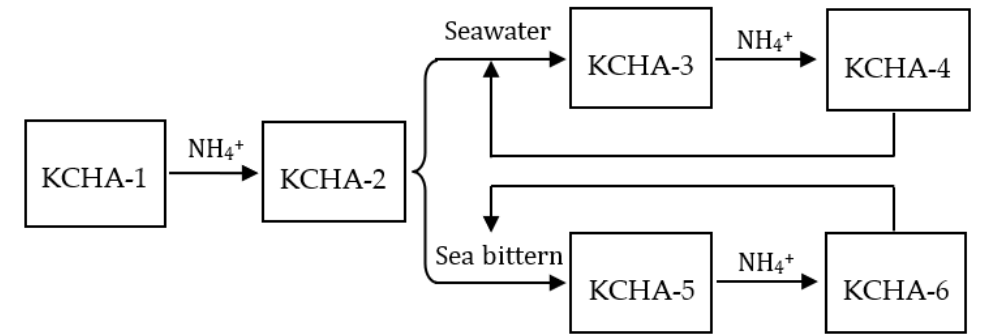
Figure 1. Diagram for modification of KCHA zeolite membrane.